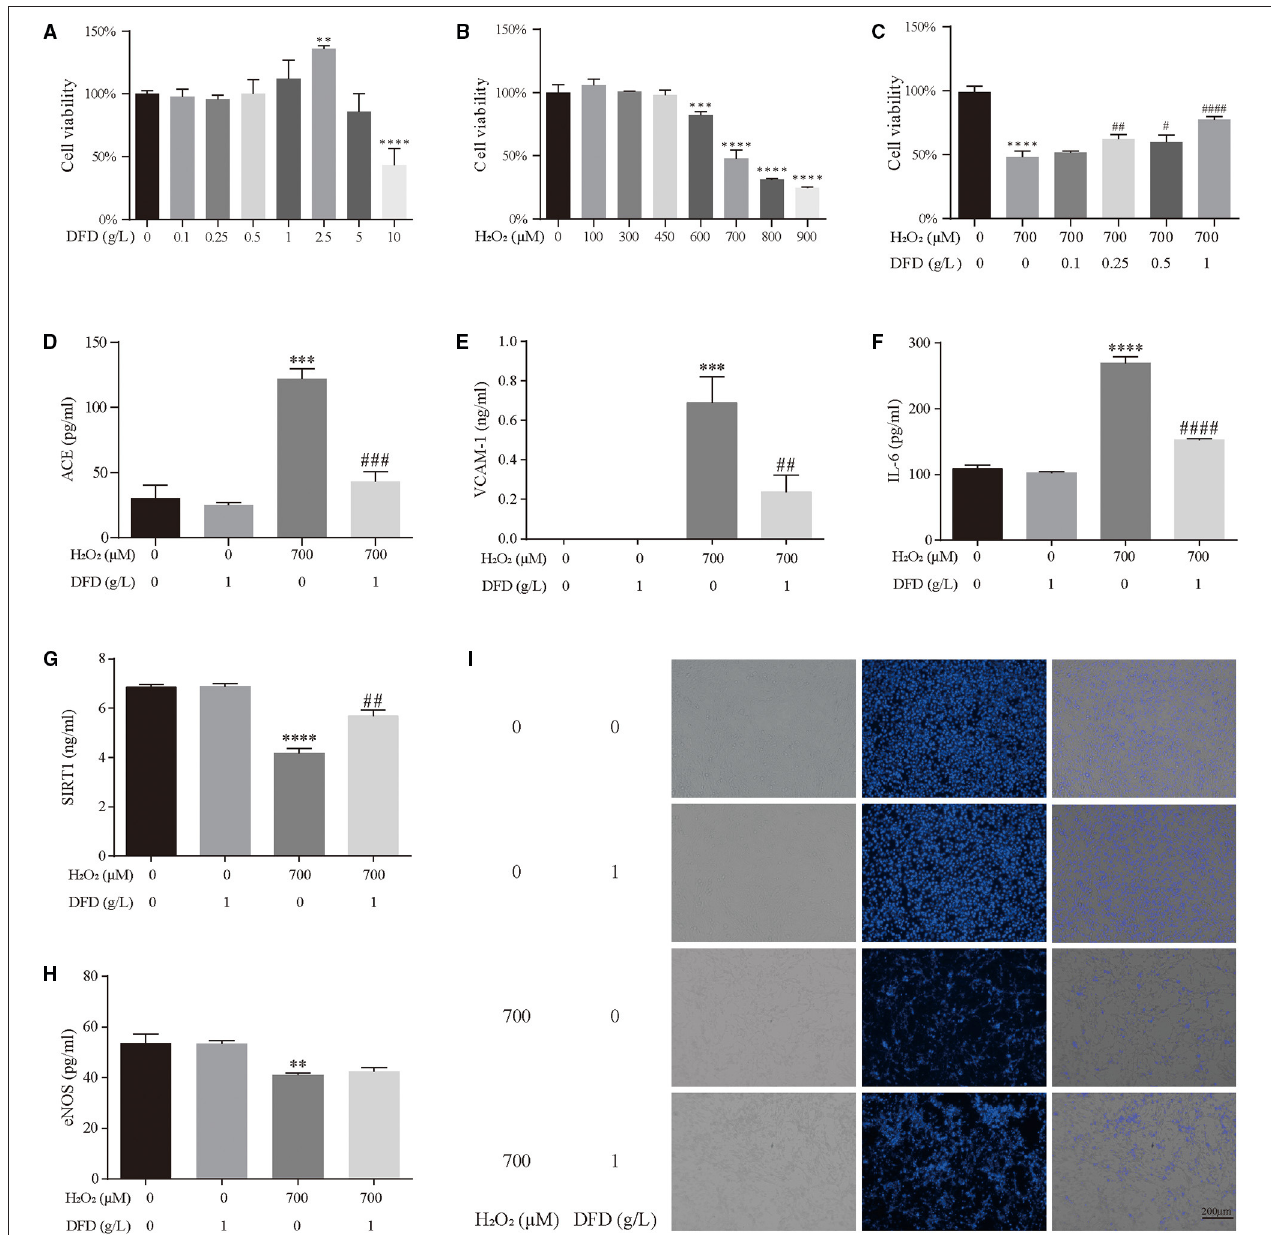
FIGURE 8 | Experimental validation. (A) The effect of DFD on the cell viability of HL-1 cells. (B) The effect of H 2 O 2 on the cell viability of HL-1 cells. (C) The effect of DFD and H 2 O 2 on the cell viability of HL-1 cells. (D) ACE. (E) VCAM-1. (F) IL-6. (G) SIRT1. (H) eNOS. (I) Hoechst 33342 stain. ** P < 0.01 compared with control group, *** P < 0.001 compared with control group, and **** P < 0.0001 compared with control group; # P < 0.05 compared with H 2 O 2 group, ## P < 0.01 compared with H 2 O 2 group, ### P < 0.001 compared with H 2 O 2 group, and #### P < 0.0001 compared with H 2 O 2